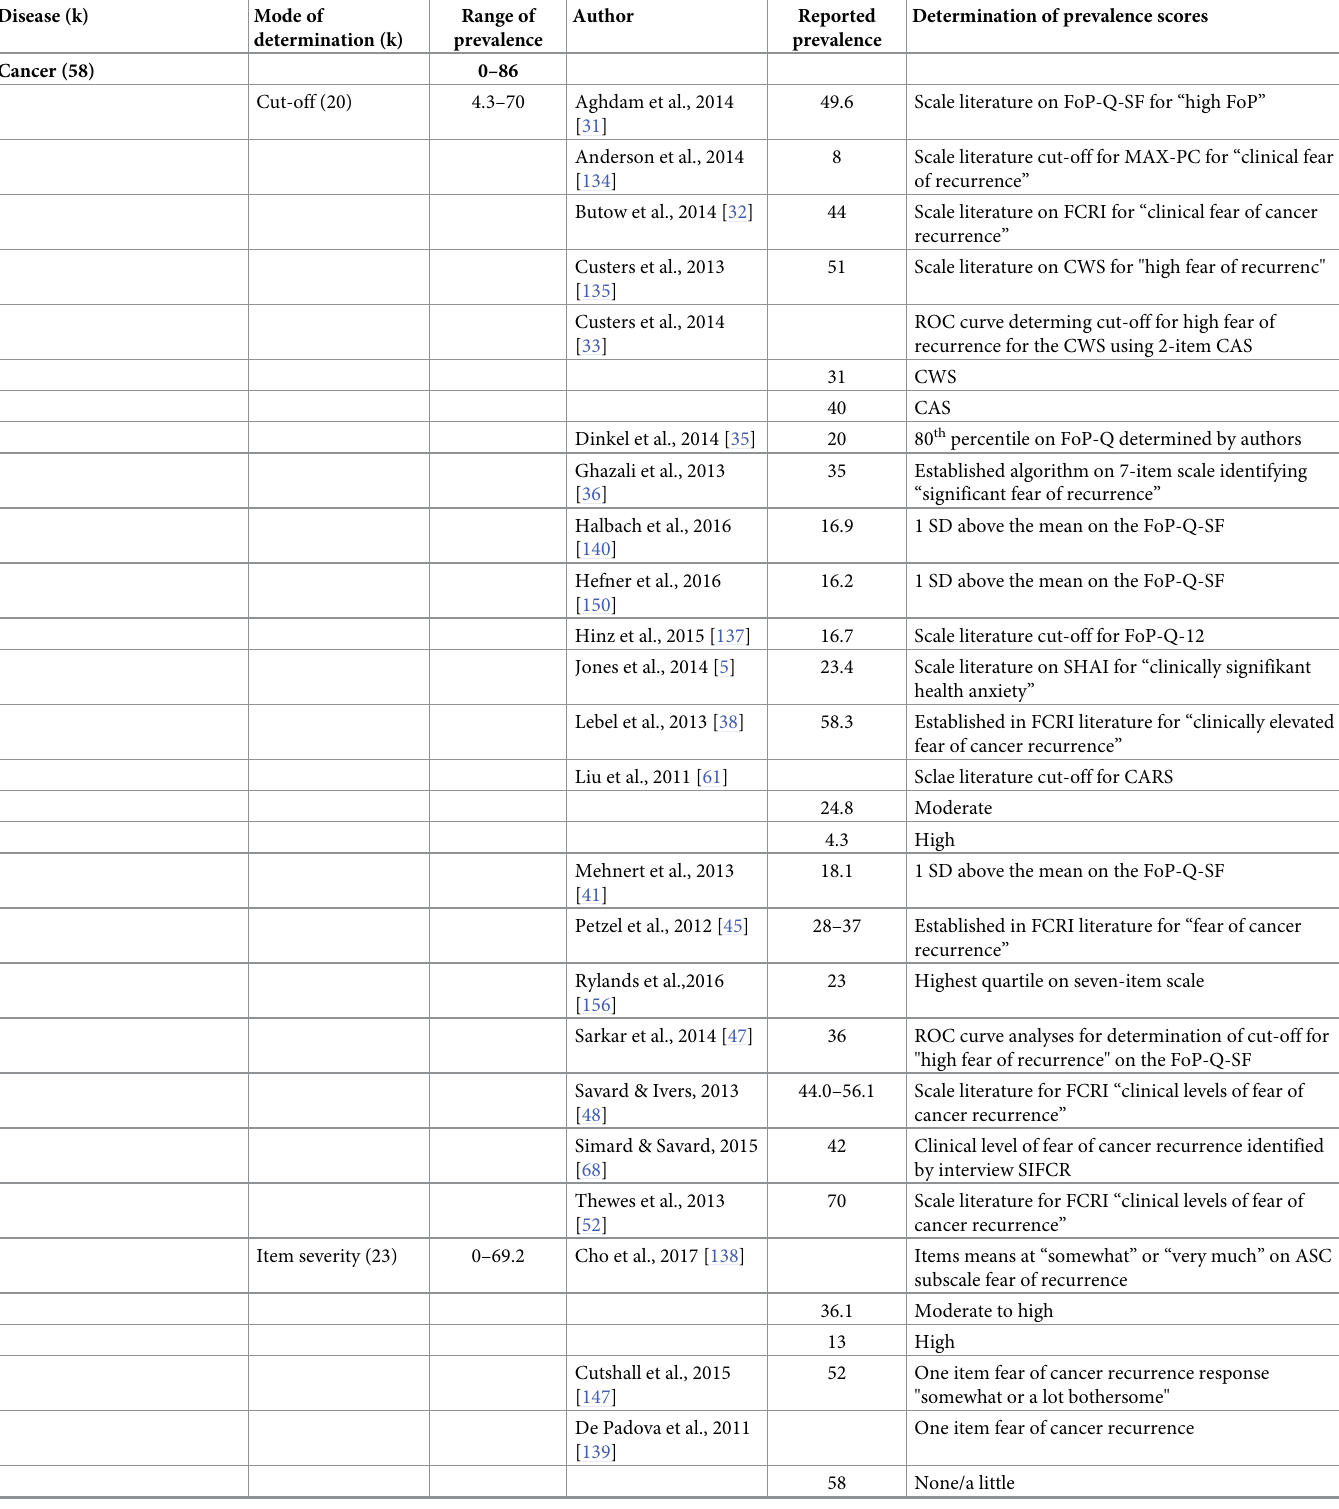
Table 5. Overall studies reporting on prevalence (%) of health anxiety by chronic illness. Disease